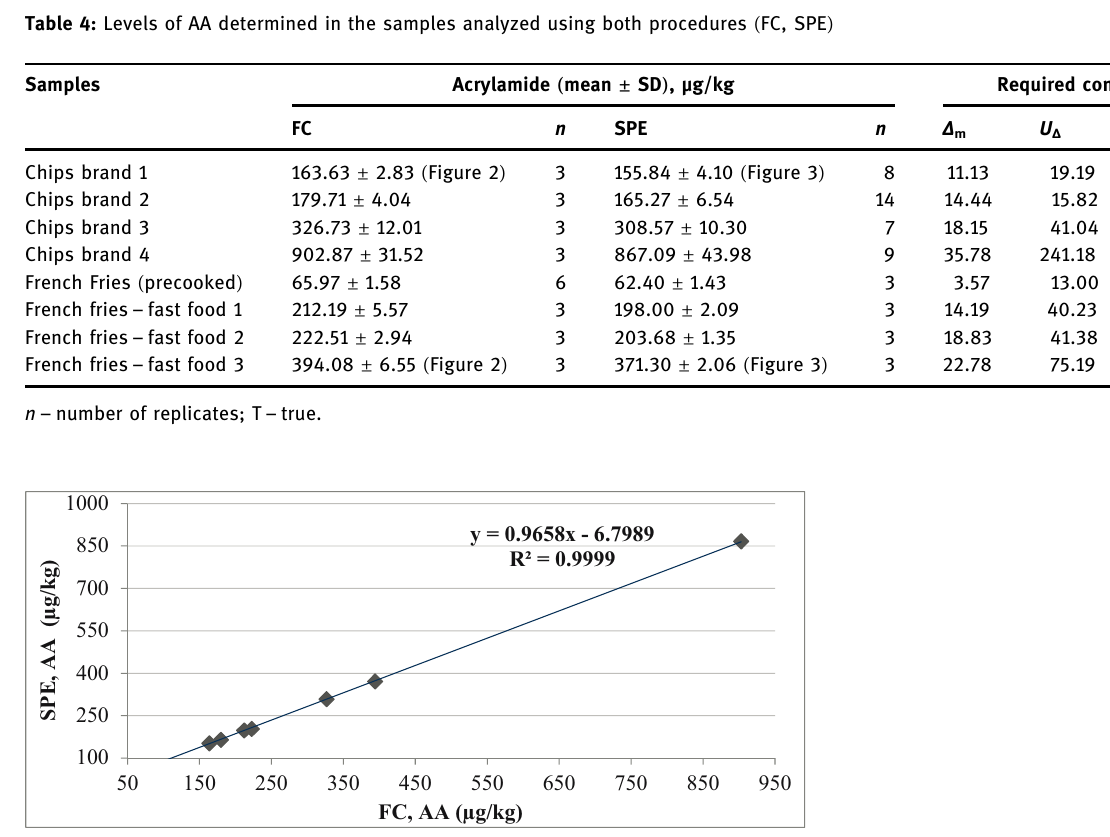
Figure 4: Graphical comparison of the two procedures used to extract AA from chips and French fries samples